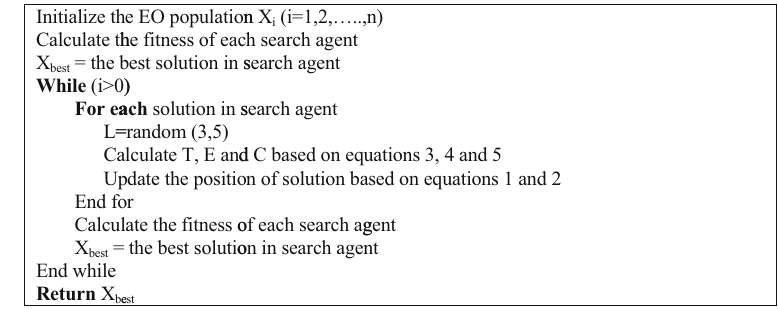
Figure 2: Pseudo code of EOO